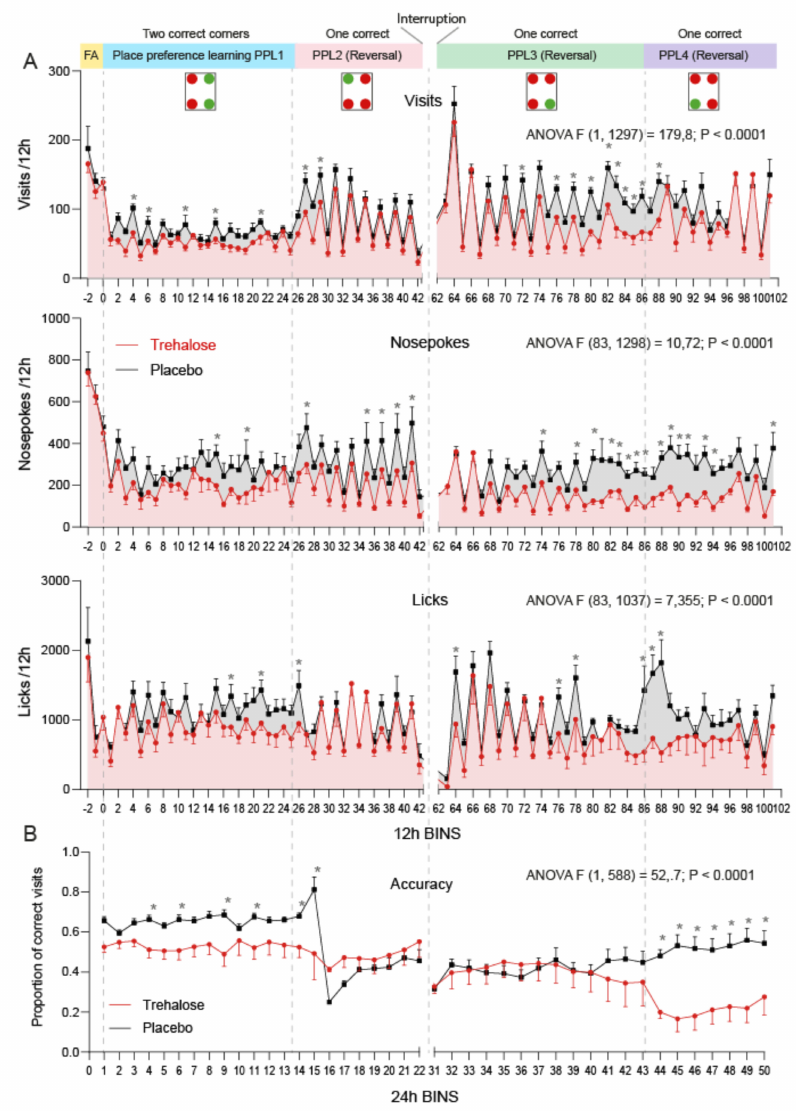
Figure 5. Activity and accuracy in Place Preference Learning (PPL) tasks in IntelliCages. Experiments started 26 weeks after SNI. ( A ): Time course of Visits, Nosepokes, and Lickings per 12 h intervals of trehalose- and placebo-treated mice ( n = 8 per group). The fluctuations show the circadian rhythms. After a short free adaptation (FA), mice were subjected to place preference tasks as depicted in the upper part of the scheme. The drawings show exemplary corner assignments: red for the forbidden corner, green for the rewarding corner(s). Trehalose and placebo were administered via drinking water in rewarding bottles. During FA, all mice received tap water. The observations in IntelliCages were interrupted for 10 days in PPL2/3 to observe reinstatement of the behavior after a home cage interval. ( B ): Time course of the proportion of correct visits in PPL tasks as depicted in A. Data are the means and sem and were compared with 2-way ANOVA for “time” x “treatment” and subsequent post hoc analysis for trehalose versus vehicle. Asterisks show p -values <